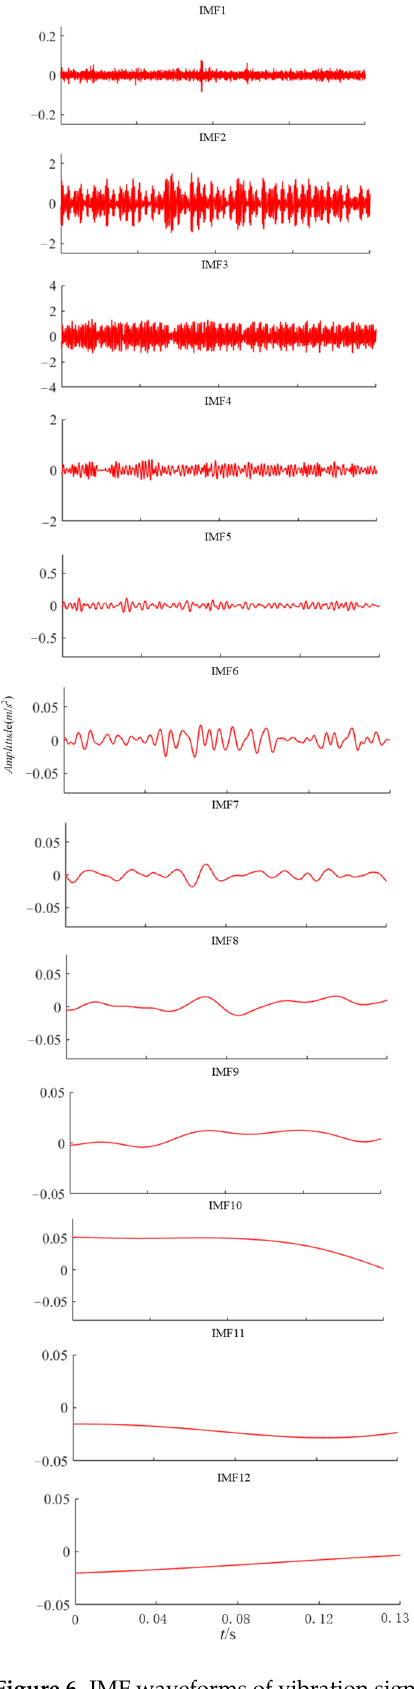
Figure 6. IMF waveforms of vibration signal of main pump in main pump normal